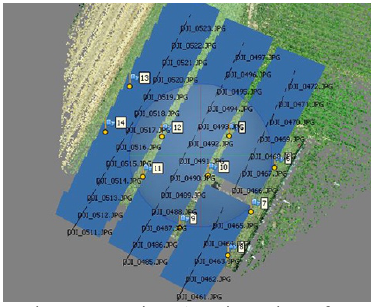
Figure 5. Project A, orientation of oblique images and extracted tie- points (sparse cloud).